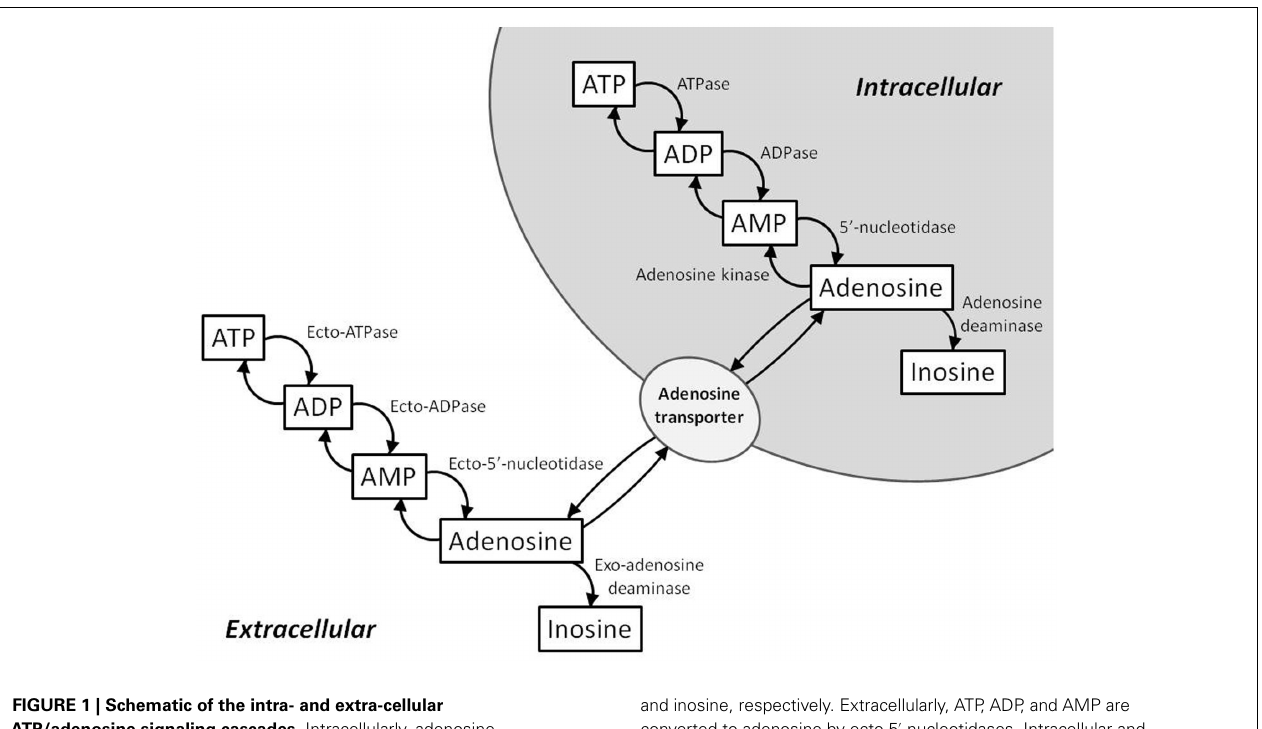
and inosine, respectively. Extracellularly, ATP, ADP, and AMP are converted to adenosine by ecto-5 (cid:2) -nucleotidases. Intracellular and extracellular adenosine levels are regulated by bi-directional equilibrative nucleoside